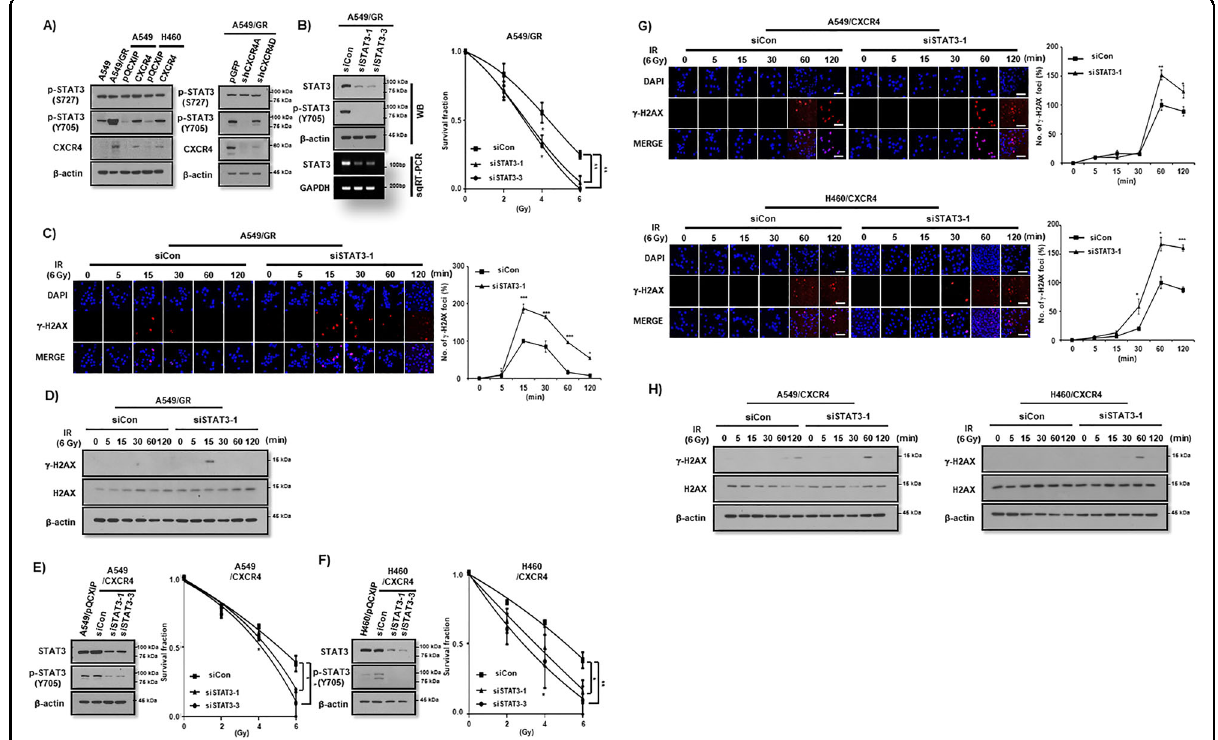
Fig. 4 CXCR4-mediated STAT3 activation is critical for IR resistance of NSCLC cells. A Western blot analysis of phopho-STAT3 (Y705 and S727) in NSCLC cells (A549, H460, and A549/GR) transfected with the vectors described in the Figure. B Western blot (WB, upper) and RT-PCR (lower) analysis (left) and IR clonogenic survival assay (right) of A549/GR cells transfected with control siRNA (siCon) or siRNA against STAT3 (siSTAT3-1 and 3-2). C , G γ -H2AX foci assay of A549/GR (C) and A549/CXCR4 (upper) and H460/CXCR4 (lower) ( G ) cells. Cells were exposed to IR (6 Gy) and fi xed at the indicated time points in the Figure. Representative ICC images of γ -H2AX (left) and quanti fi cation of the results (right). * P < 0.05, ** P < 0.01, *** P < 0.005. White bar: 20 μ m. D , H Western blot analysis of A549/GR ( D ) and A549/CXCR4 (left) and H460/CXCR4 (right) ( H ). Cells exposed to IR (6 Gy) at the indicated time points transfected with control siRNA (siCon) or siRNA against Stat3 (siSTAT3-1). E , F Western bot analysis of p-STAT3 (S727 and Y705) (left) and IR clonogenic survival assay (right) in A549 ( E ) and H460 ( F ) cells transfected with control siRNA (siCon) or siRNA against STAT3 (siSTAT3-1 and